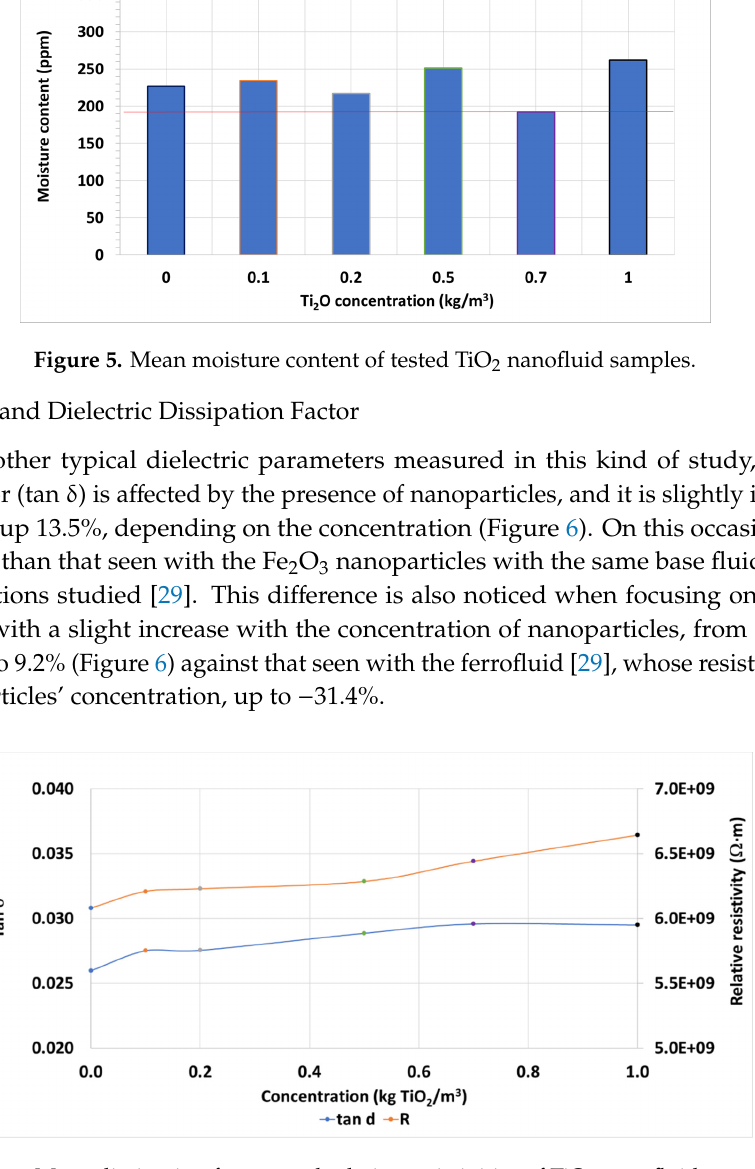
Figure 6. Mean dissipation factors and relative resistivities of TiO 2 nanofluid